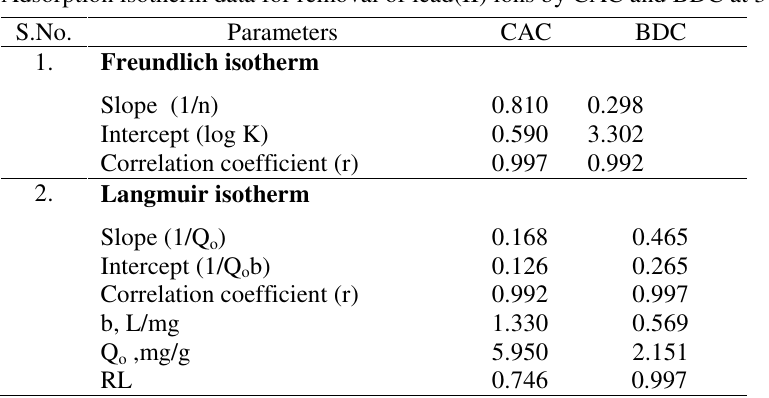
Table 2 . Adsorption isotherm data for removal of lead(II) ions by CAC and BDC at 30 ° C